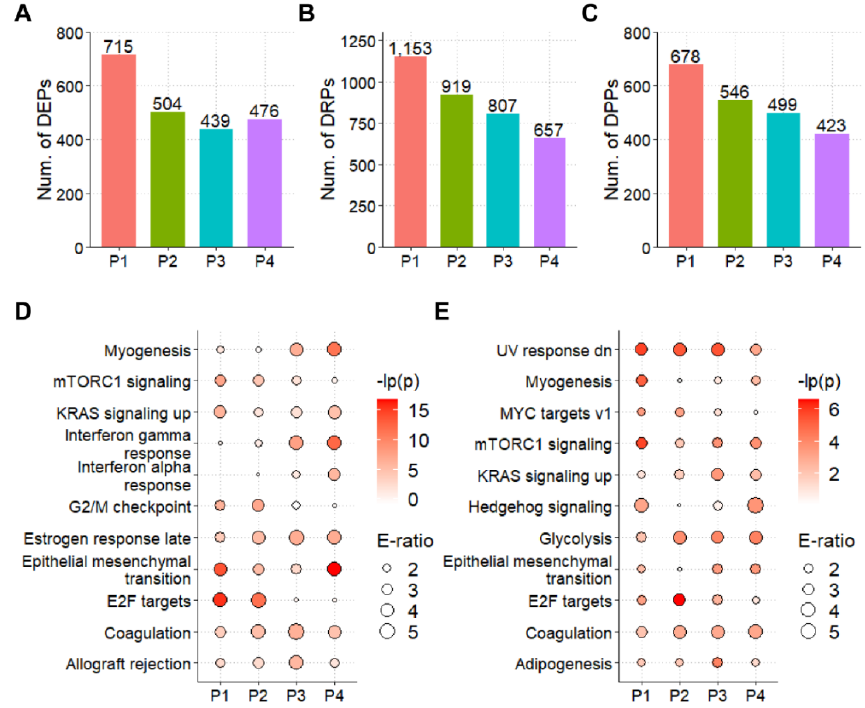
Figure 3. The functional enrichment analysis of CCAs: the numbers of ( A ) DEPs, ( B ) DPRs, and ( C ) DPPs of CCA tumors against their corresponding NATs; the MSigDB-based functional enrichment analysis for ( D ) DEPs and ( E ) DPPs.